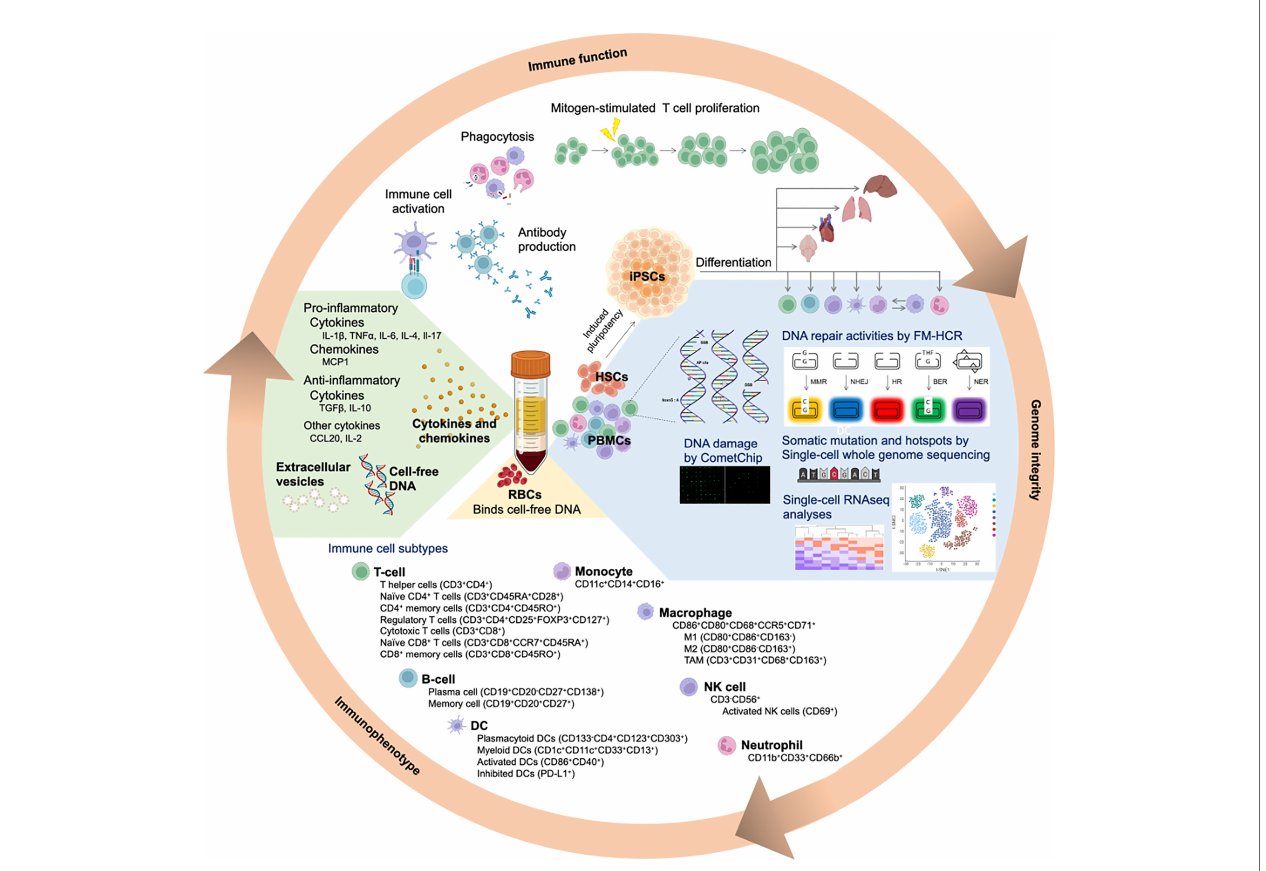
FIGURE 3 | Simultaneous assessment of genome integrity and immune function using human blood samples. Following density gradient centrifugation of peripheral blood, peripheral blood mononuclear cells (PBMCs) are enriched in the buffy coat layer. Different immune cell subtypes within the PBMC population can be further identi fi ed based on their speci fi c cell markers. Genomic integrity of the immune cell subtypes can be comprehensively evaluated by integrating various complementary approaches. Fluorescence-based multiplex host cell reactivation (FM-HCR) evaluates the ability of cells to repair speci fi c DNA lesions. The CometChip assay reveals the magnitude of genomic DNA damage and repair kinetics in a high throughput manner. Single-cell whole genome sequencing identi fi es somatic mutations, whereas RNAseq (CITE-seq and single-cell RNAseq) measure the transcriptome. Moreover, hematopoietic stem cells isolated from the blood sample can potentially be used to generate induced pluripotent stem cells (iPSCs). Upon differentiating these iPSCs into a somatic cell type of interest, it becomes feasible to obtain large number of patient-derived, tissue-speci fi c somatic cells, which may otherwise be scarce or not feasible to obtain. Red blood cells (RBCs), which are enriched in the bottom layer, bind cell-free DNA to minimize in fl ammatory responses. The plasma layer contains cytokines and chemokines secreted from the immune cells. These signaling molecules can be pro-in fl ammatory or anti-in fl ammatory, depending on the cellular status and presence of antigens. Notably, cell- free DNA and extracellular vesicles (EVs) are present in